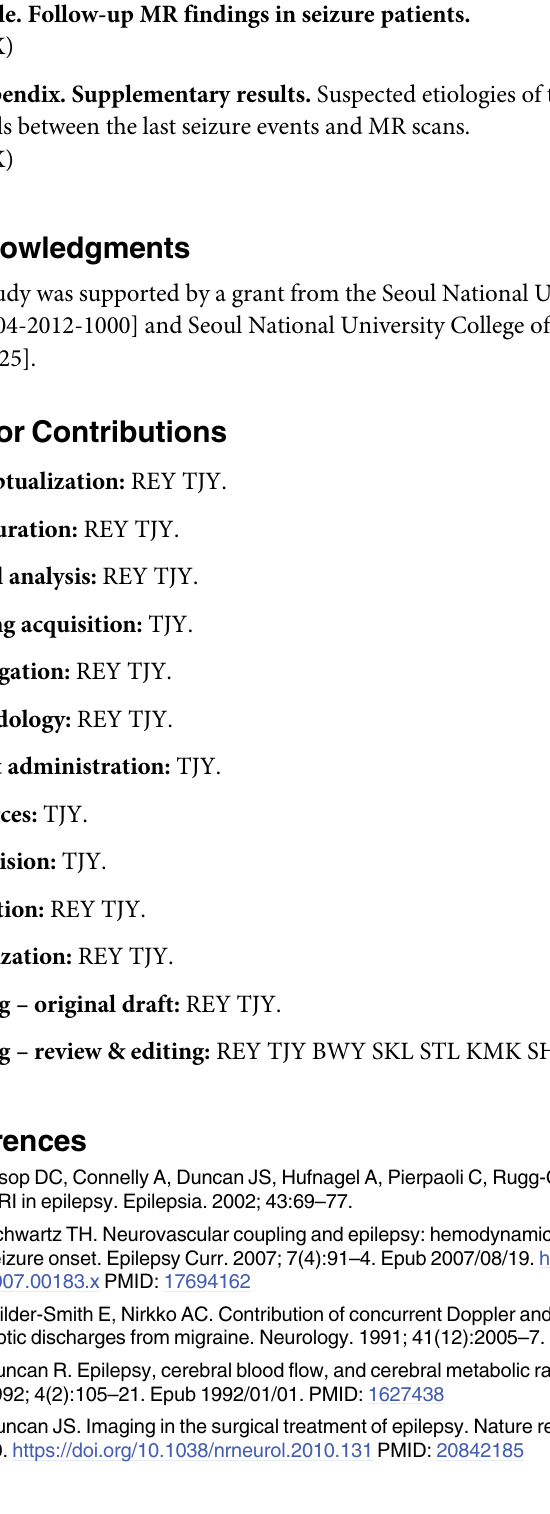
S1 Table. MR imaging parameters. S2 Table. Follow-up MR findings in seizure